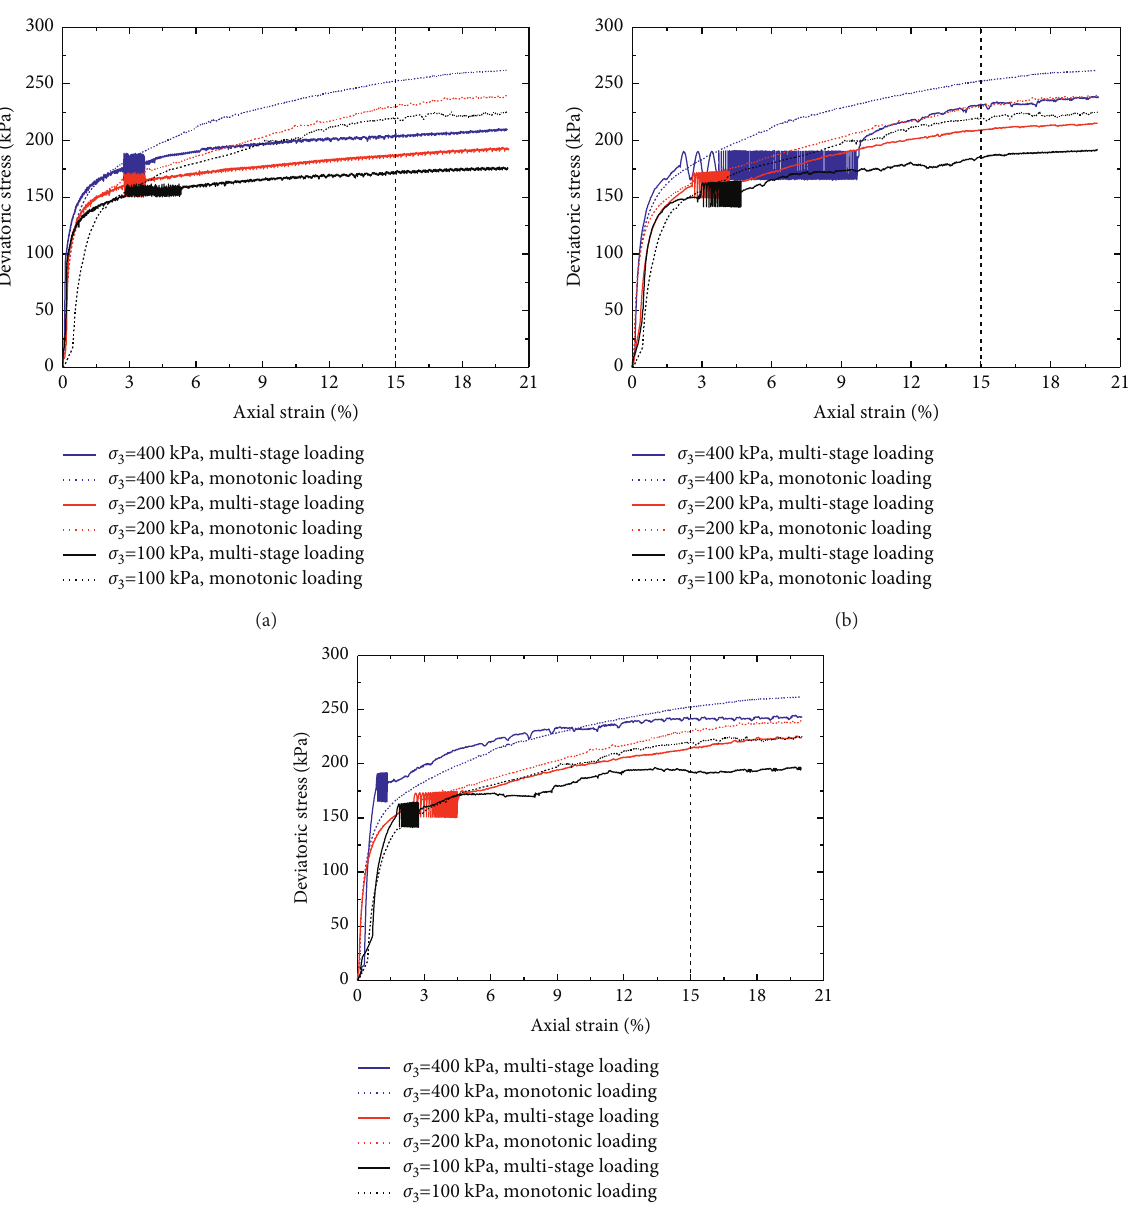
Figure 7: Deviatoric stress versus axial strain at different confining stresses ( N � 100). (a) T � 10s; (b) T � 60 s; (c) T �